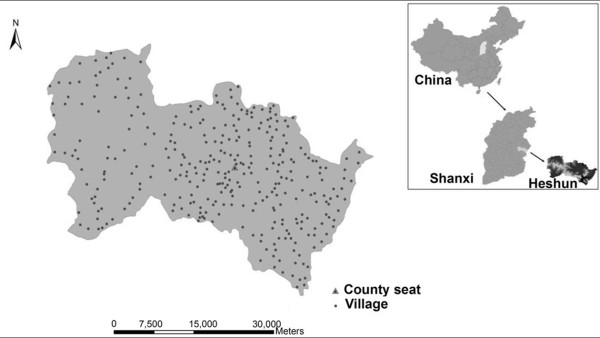
Location of Heshun.